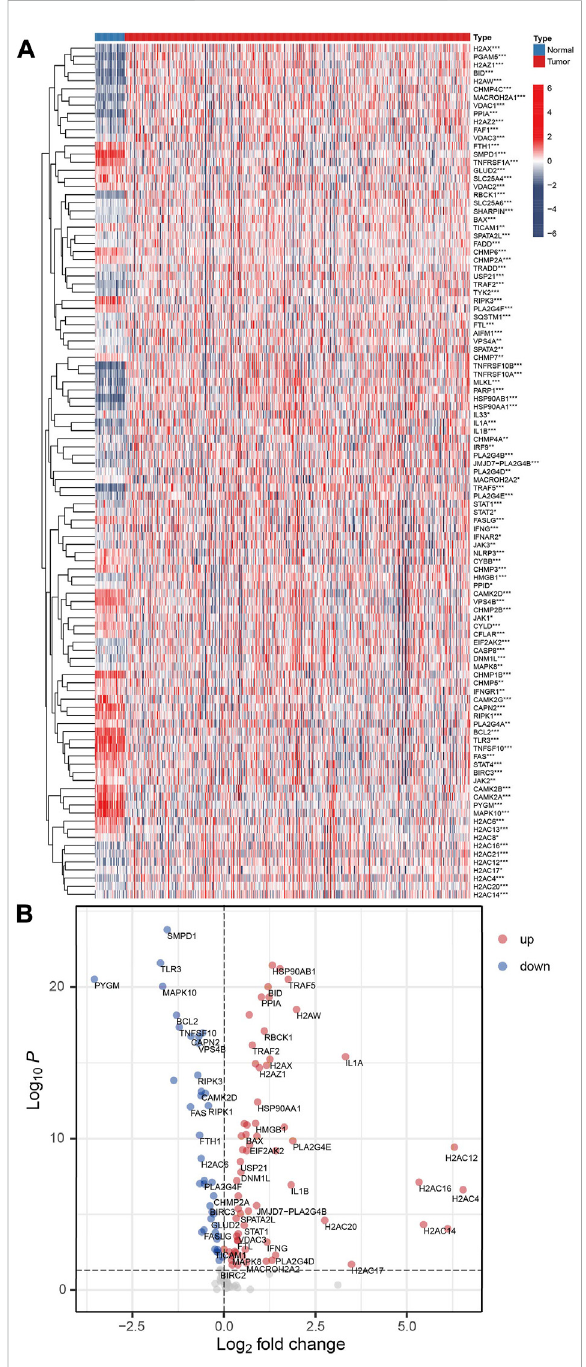
FIGURE 2 The differentially expressed NRGs. (A) Heatmap for the 105 differentially expressed NRGs. Red is tumor tissue samples, andblueisnormalsamples(* p < 0.05;** p < 0.01;*** p < 0.001). (B) A volcano plot of NRGs. Up-regulated and down-regulated genes are indicated by red and blue,